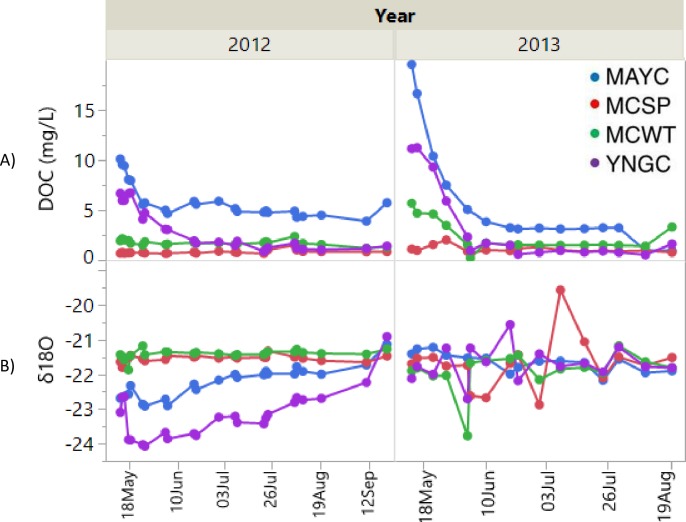
Seasonal and interannual trends.(A) DOC concentration and (B) water δ18O for Creek (MAYC and YNGC), subsurface fed spring (MCSP), and mixed source (MCWT) sites.